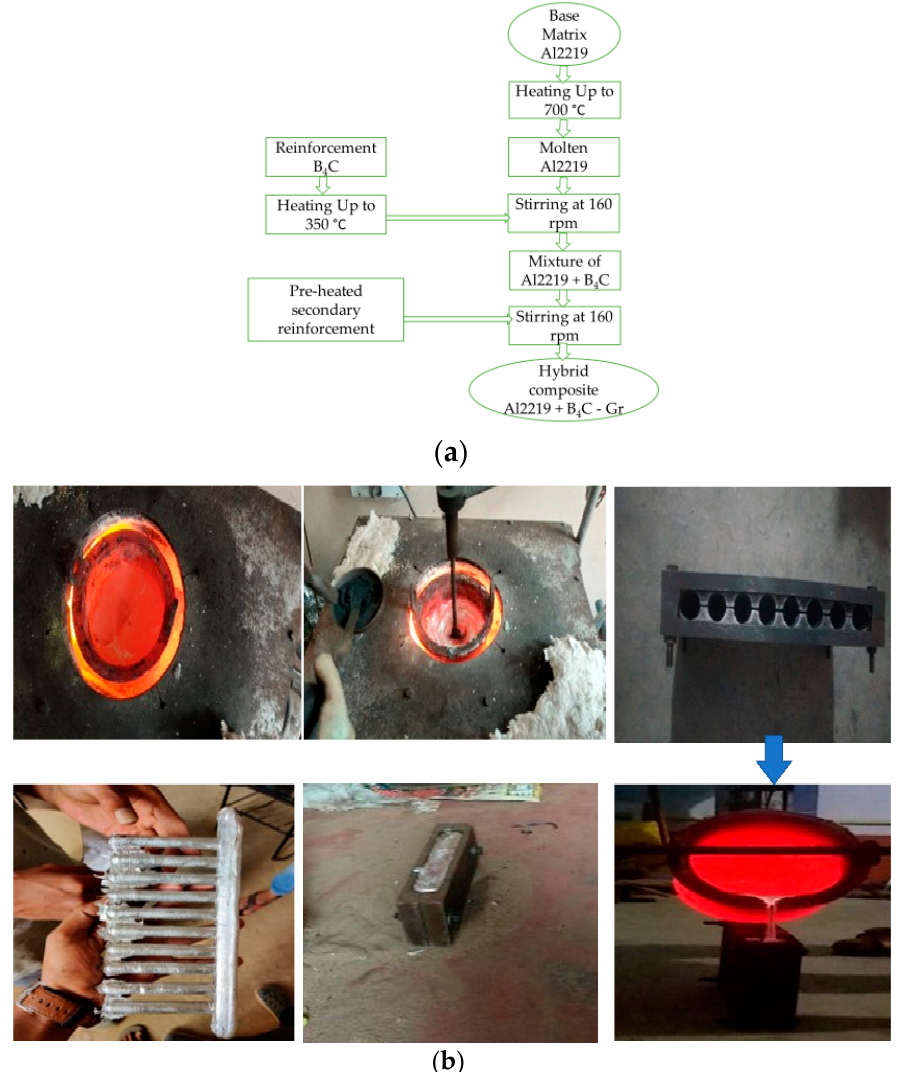
Figure 1. ( a ) Methodology adopted for hybrid composite casting: ( b ) Steps for hybrid composite casting. Table 2. Percentage of particulate reinforcement by weight